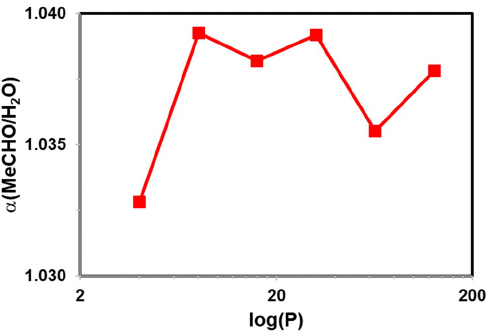
Figure 3. Computed 18 O/ 16 O equilibrium isotope fractionation for acetaldehyde in water versus the number of quasi-particles P used in path integral simulations.